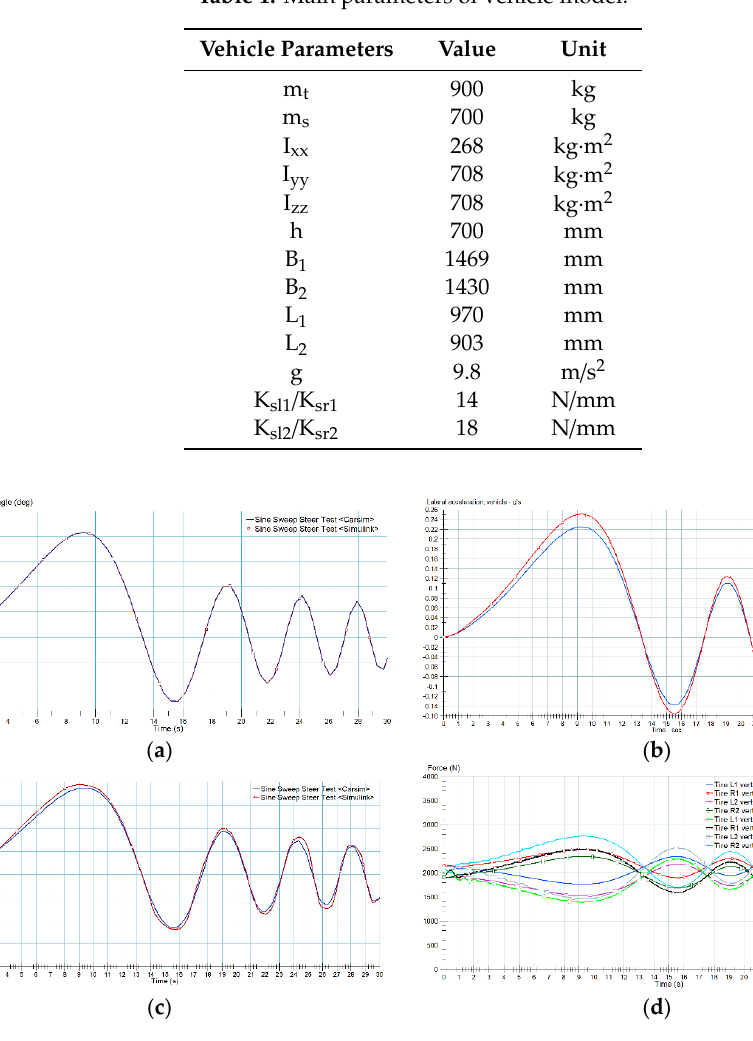
Figure 3. Model comparison results (red solid line with little square is the result of the Simulink simulation; blue solid line is the result of the CarSim simulation except in ( d )). ( a ) is the input steering angle; ( b ) is the comparison of the lateral acceleration; ( c ) is the comparison of the roll angle; ( d ) is the comparison of the vertical force of each wheel. Table 1. Main parameters of vehicle model. Table 2. Main results of